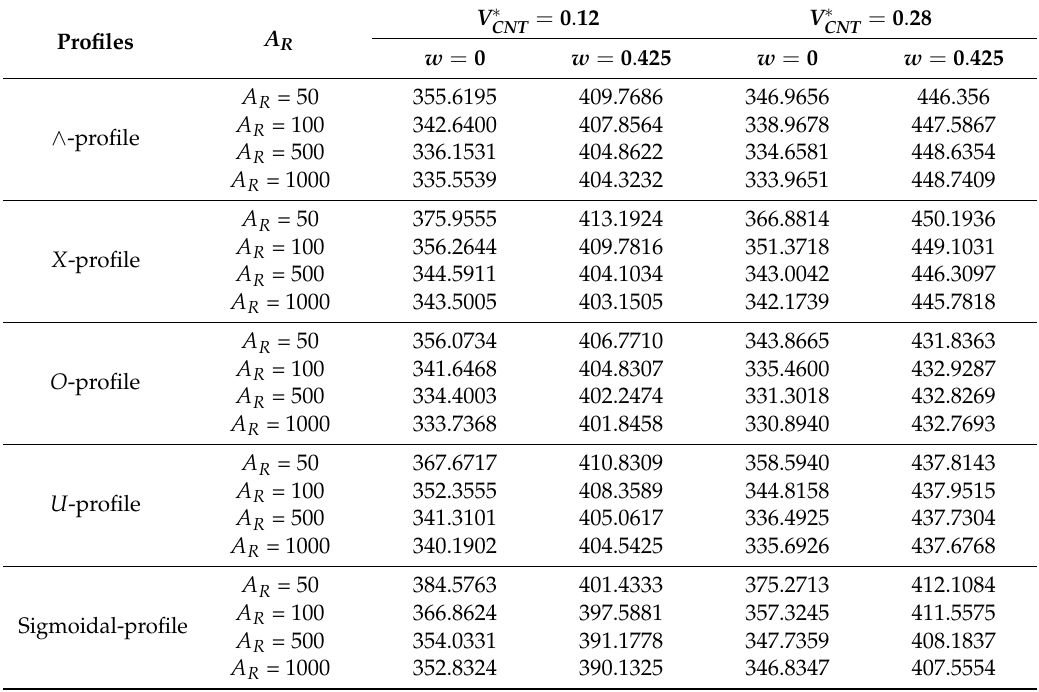
Table 3. Critical thermal buckling load for different distributions of the CNTs within the